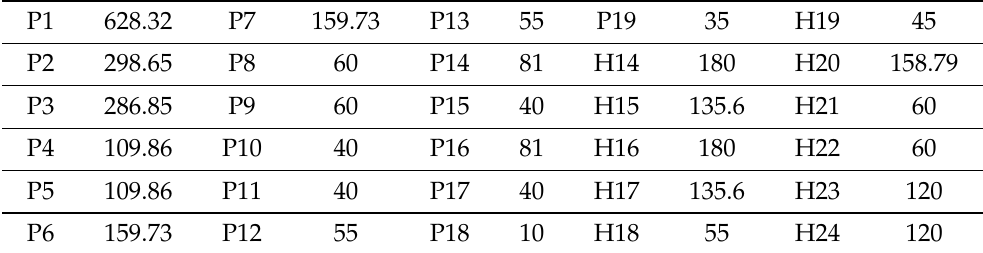
Table 10. Optimal schedule for the best cost obtained for Case study 4.